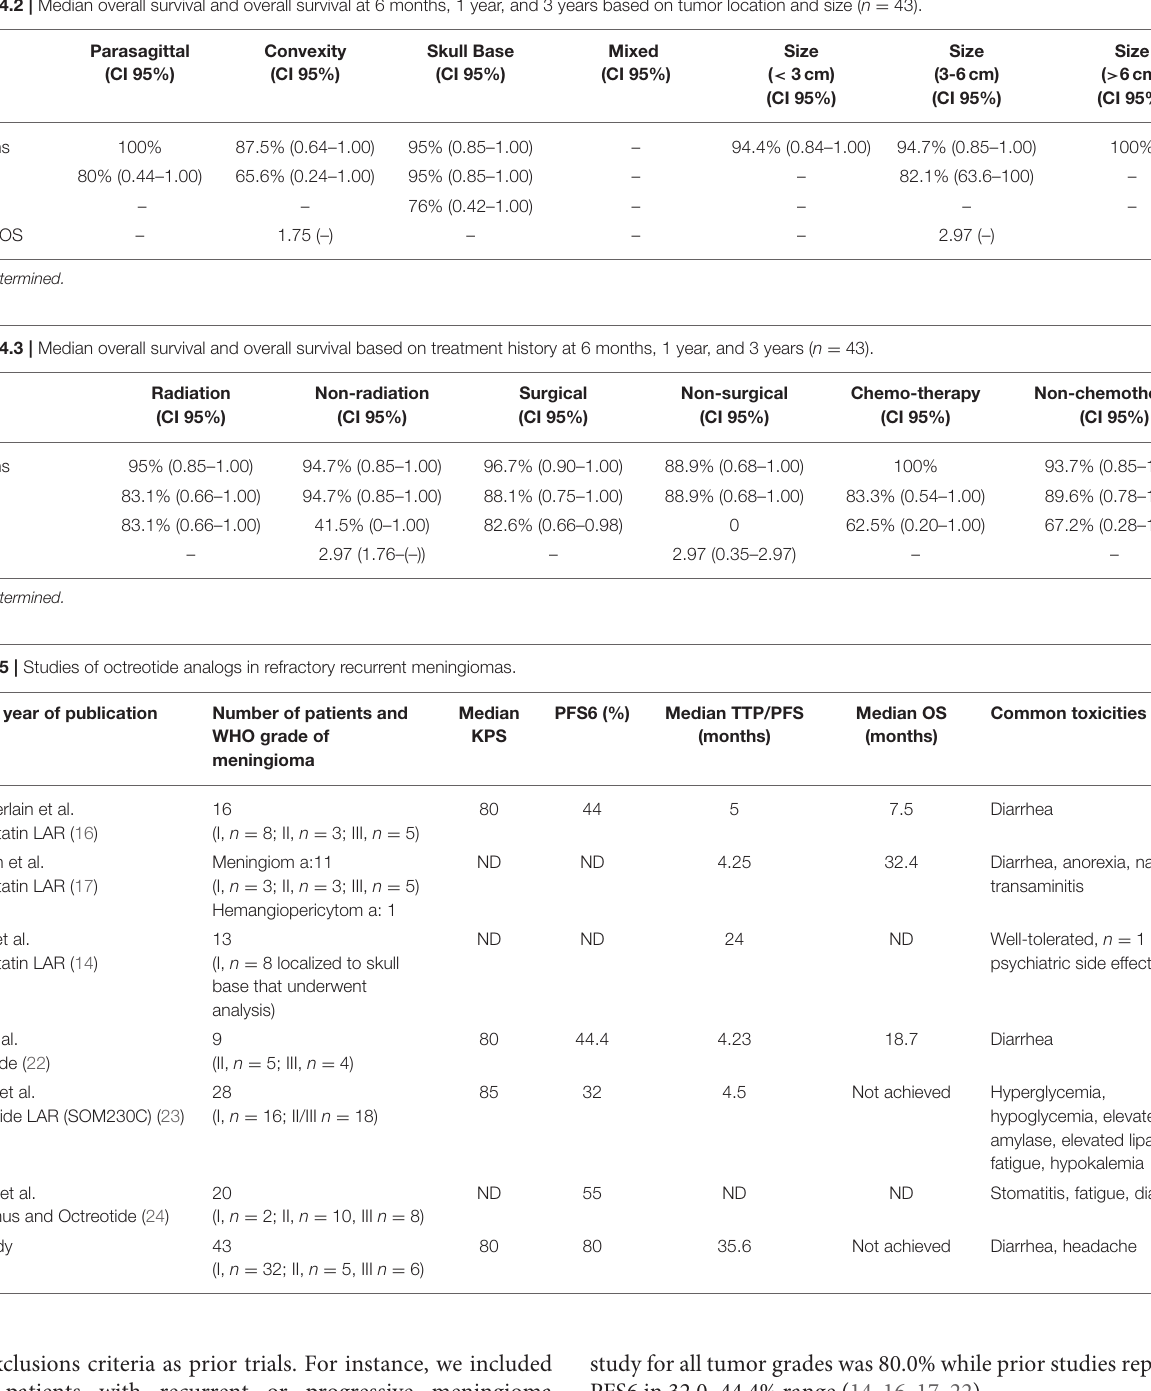
TABLE 4.2 | Median overall survival and overall survival at 6 months, 1 year, and 3 years based on tumor location and size ( n = 43).